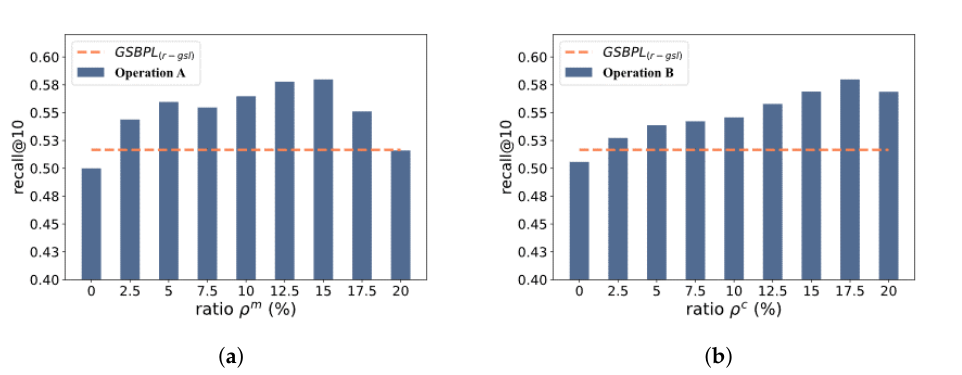
Figure 5. Effectiveness visualization of data augmentation: ( a ) Operation A; ( b ) Operation